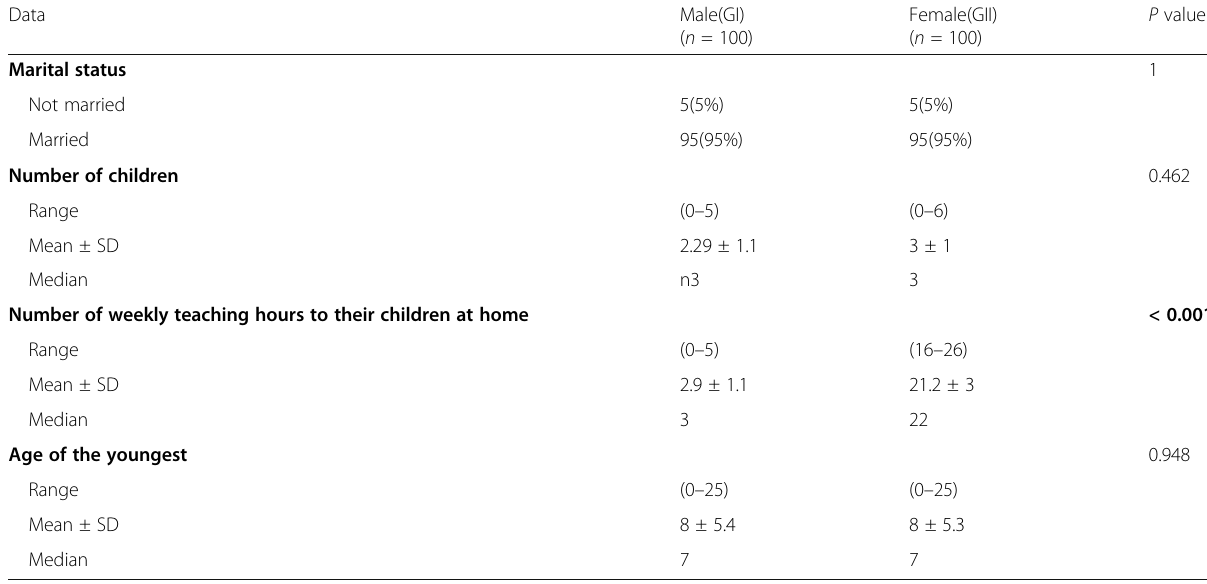
Table 2 Comparison between male and female teachers regarding social factors Data